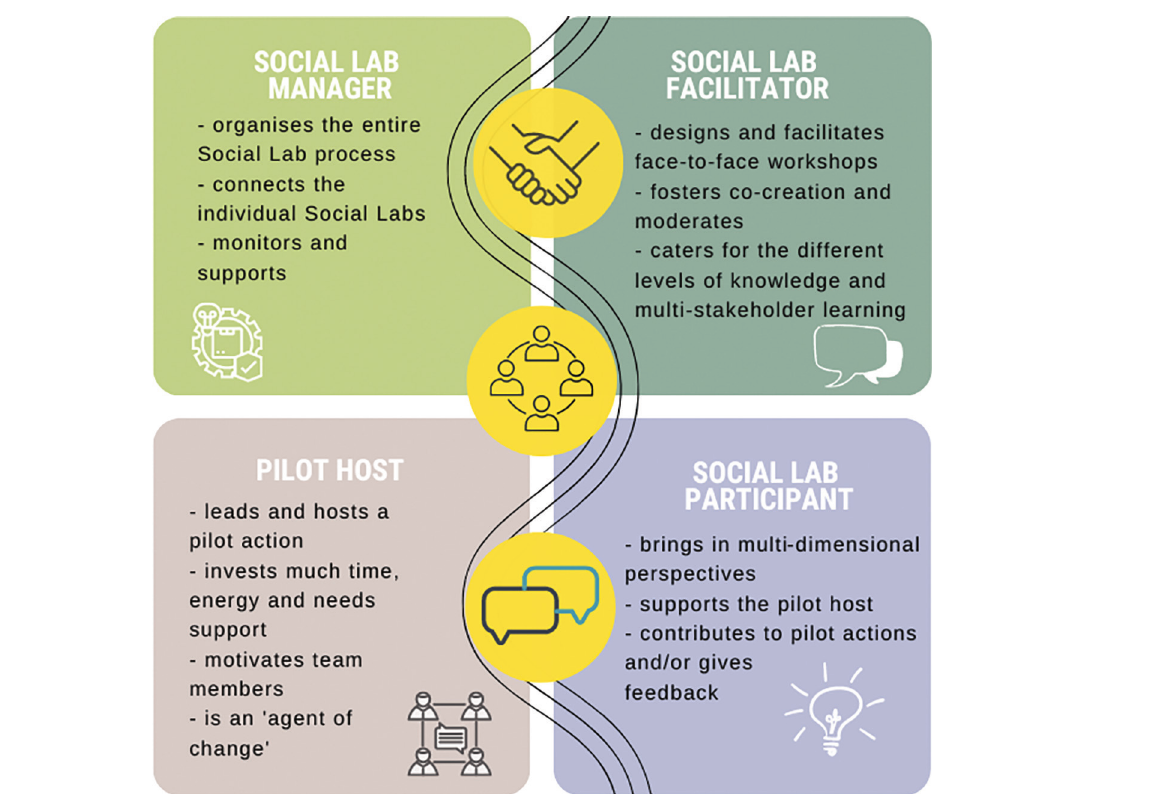
Figure 2. Roles and responsibilities in a Social Lab (Source: Authors,